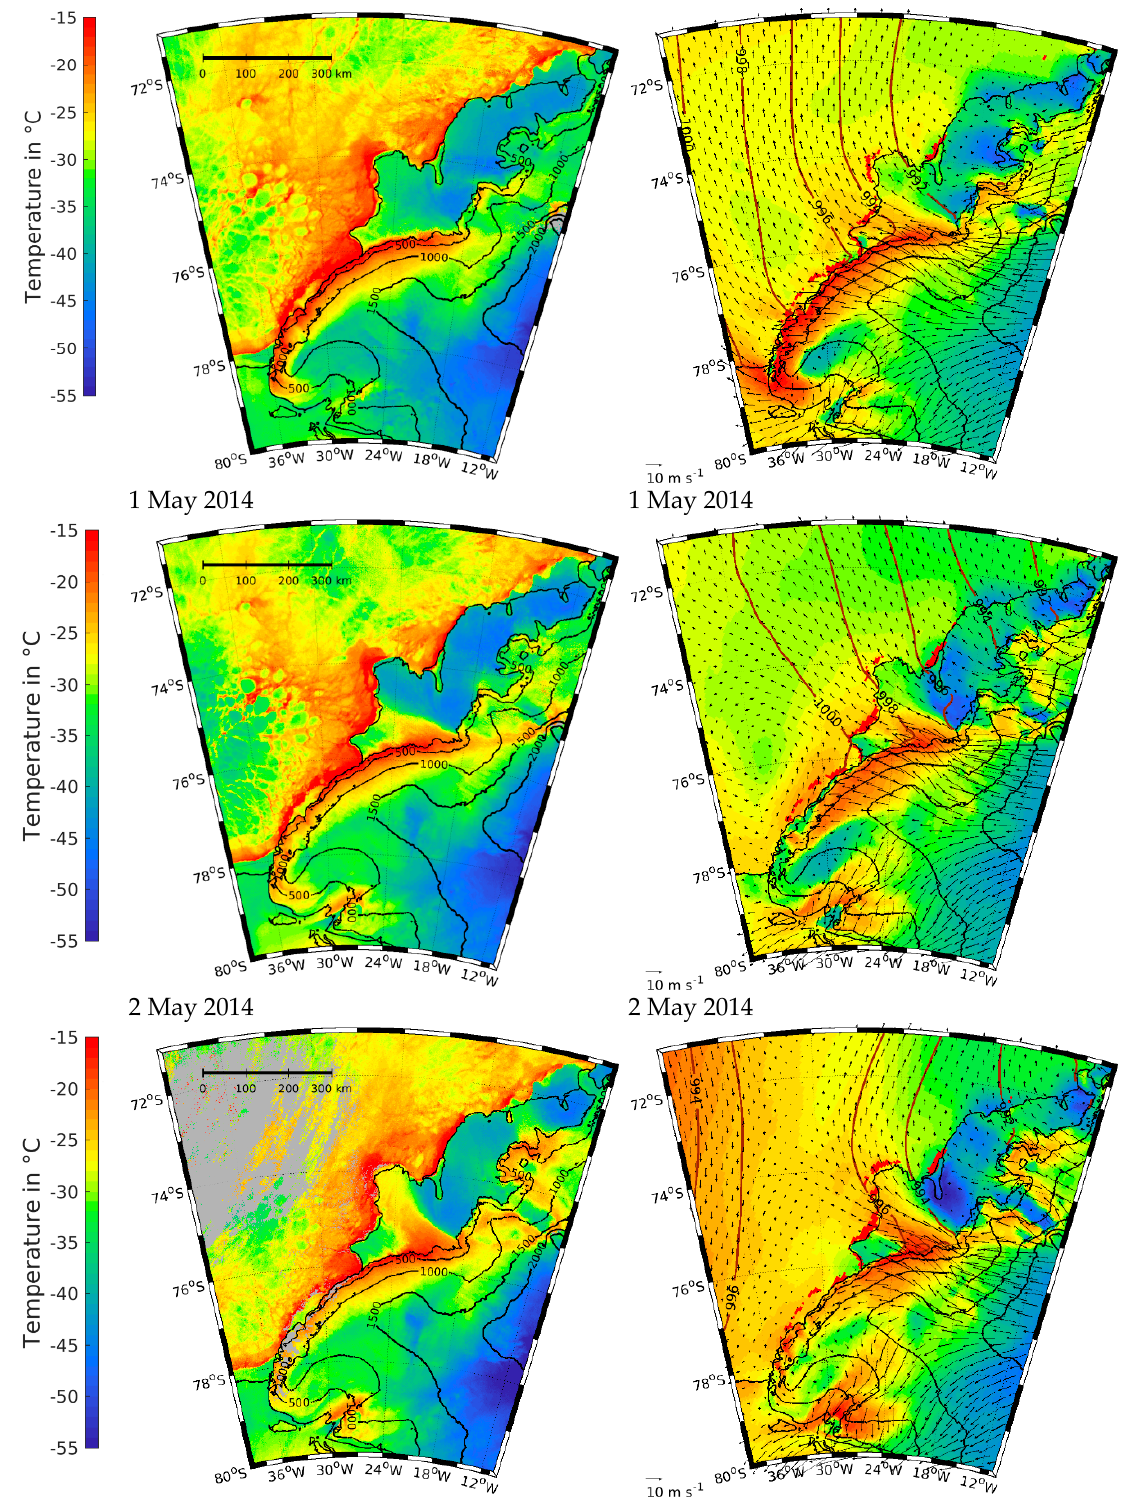
Figure 12. Daily composite of MODIS surface temperature (left column) and simulated CCLM daily averages of surface temperature, MSLP (isolines) and 10m-wind vectors (right column) for 30 April 2014 (upper row), 1 May 2014 (middle row) and 2 May 2014 (lower row).